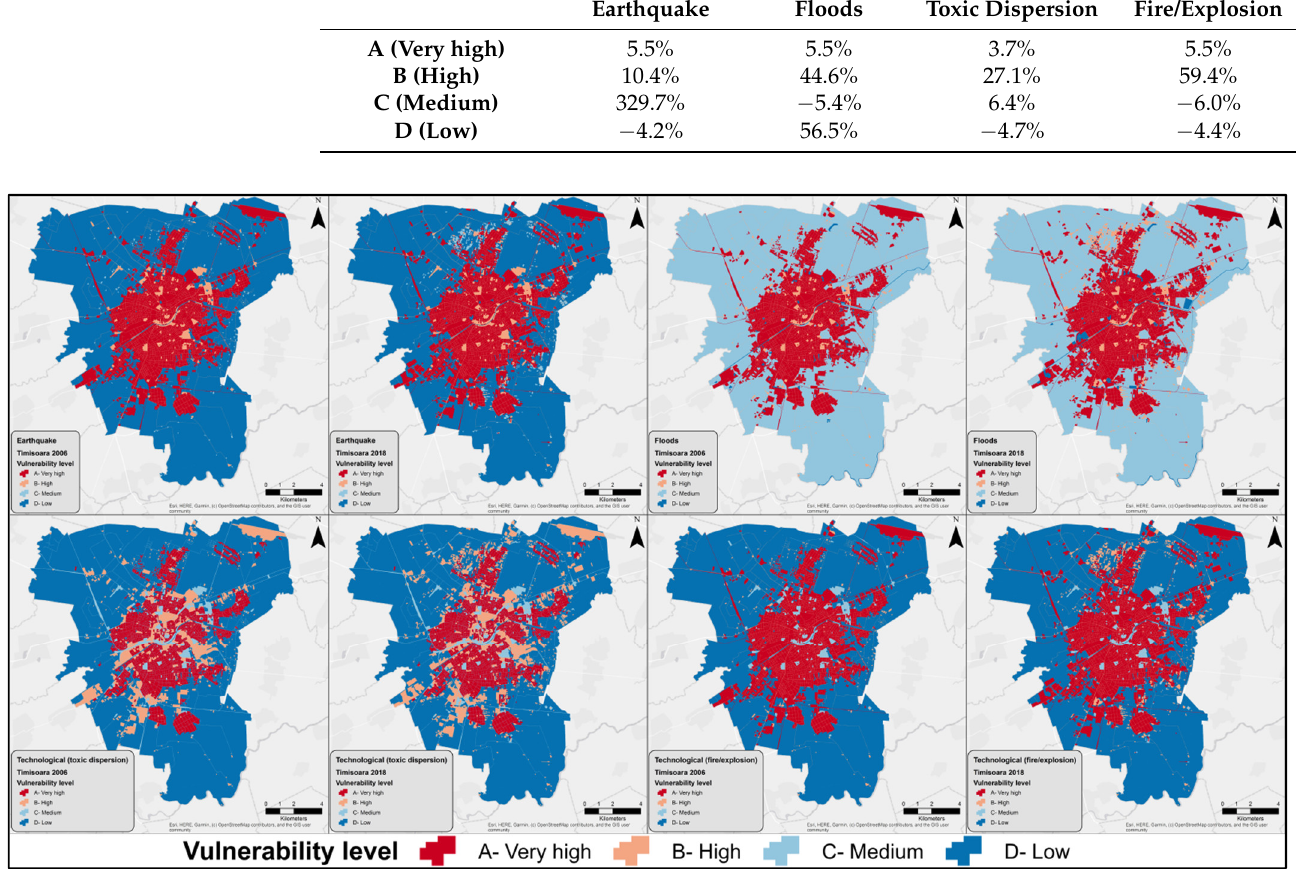
Figure 5. Visualization of temporal and spatial variation in vulnerability level for Timișoara FUA.